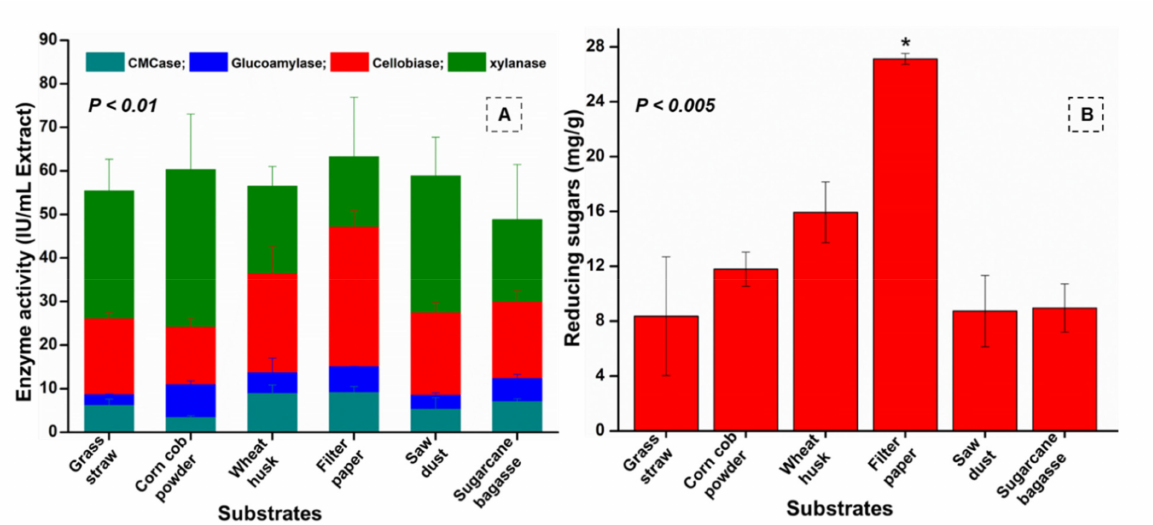
Figure 5. ( A ) Profile of the enzyme activities of B. altitudinis RSP75 on different carbon sources used as substrates after 8 days of incubation. ( B ) Reducing sugar production by B. altitudinis RSP75 on different substrates. The asterisk (*) indicates reducing sugar production statistically significant at p < 0.005 on FP when compared with other